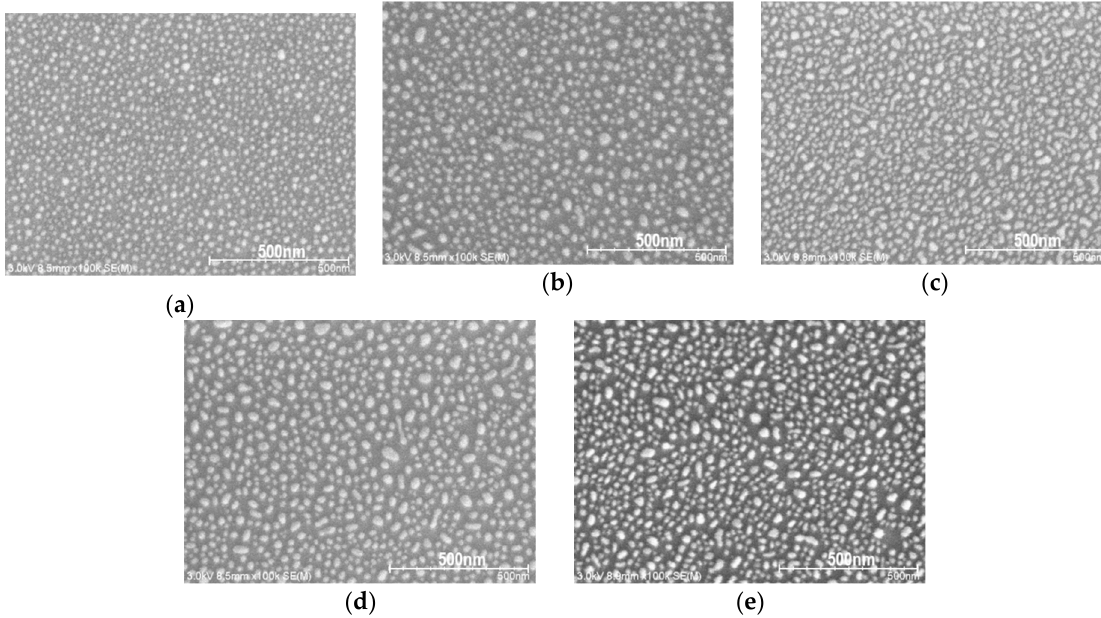
Figure 2. Top view SEM images of ( a ) NPs 1 on the u-GaN layer, ( b ) NPs 2 on the u-GaN layer, ( c ) NPs 3 on the u-GaN layer, ( d ) NPs 4 on the u-GaN layer, and ( e ) NPs 5 on the u-GaN layer.